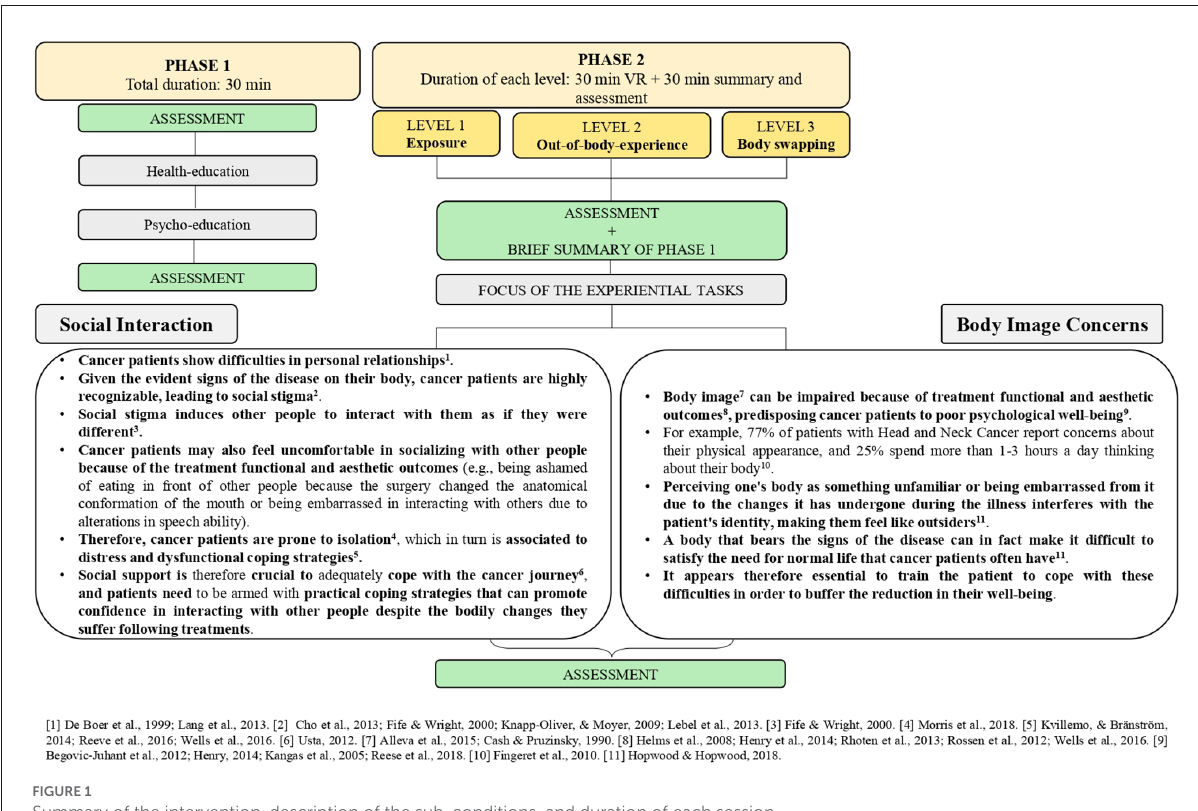
FIGURE1 Summary of the intervention, description of the sub-conditions, and duration of each